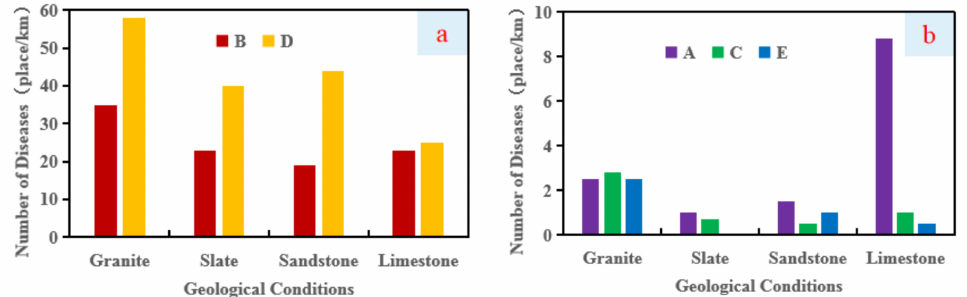
Figure 4. Number of diseases per kilometer under various geological conditions (( a ): types accounting for more than 20%; ( b ): types accounting for less than